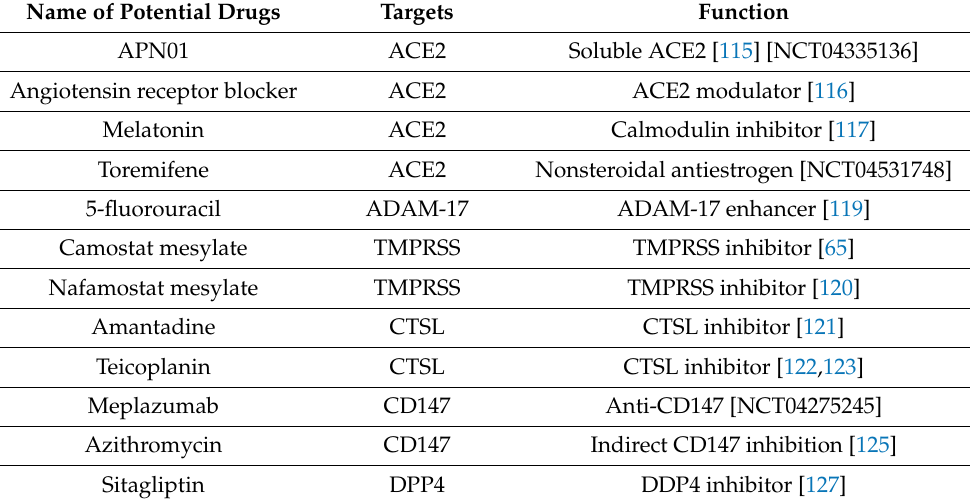
Table 1. Potential drugs for the treatment of